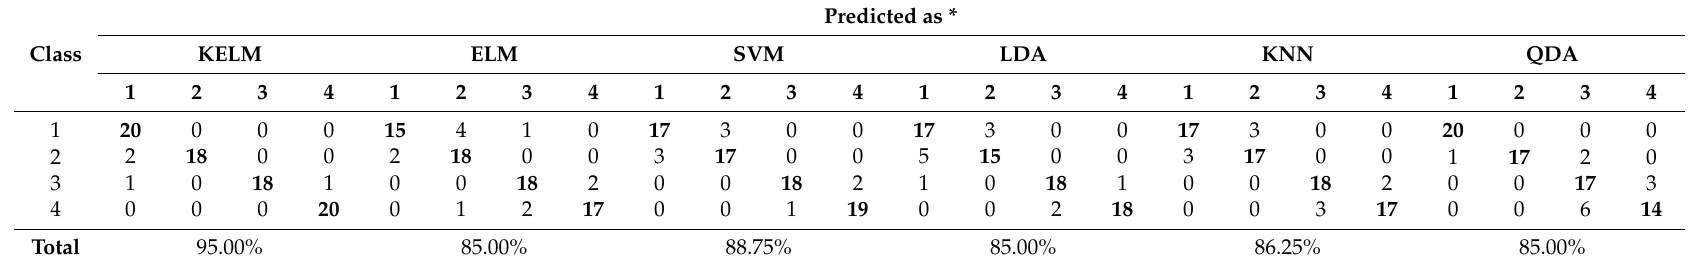
Table 4. Classification results of wavelet